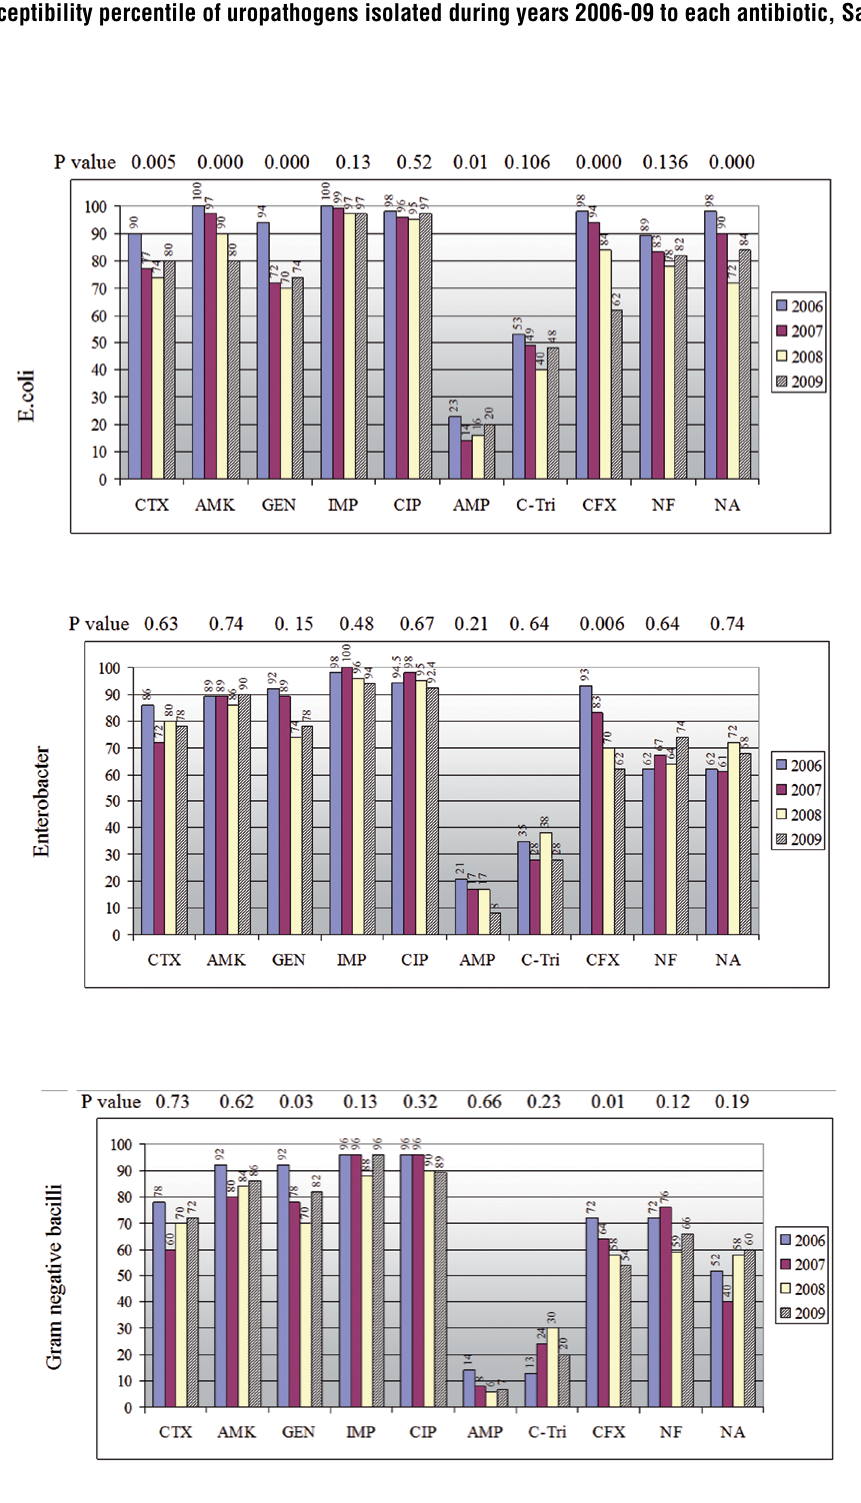
Figure 1 – The susceptibility percentile of uropathogens isolated during years 2006-09 to each antibiotic,